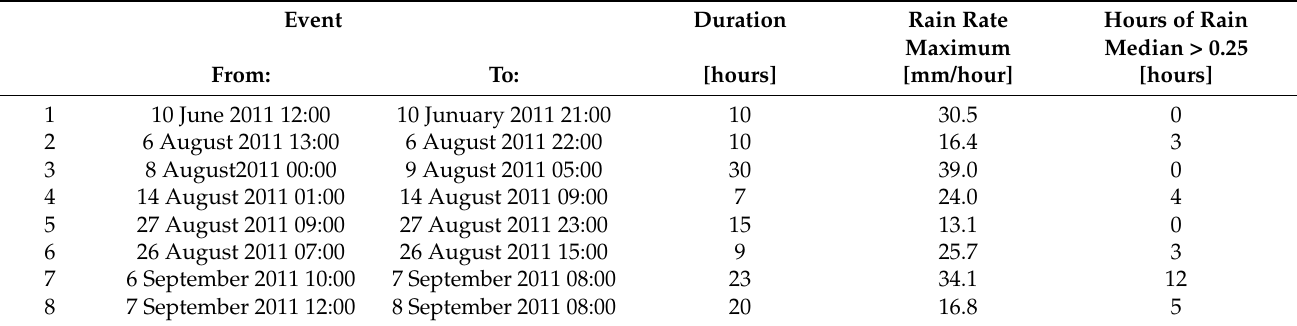
Table 3. Rain events used for validation in the Netherlands.